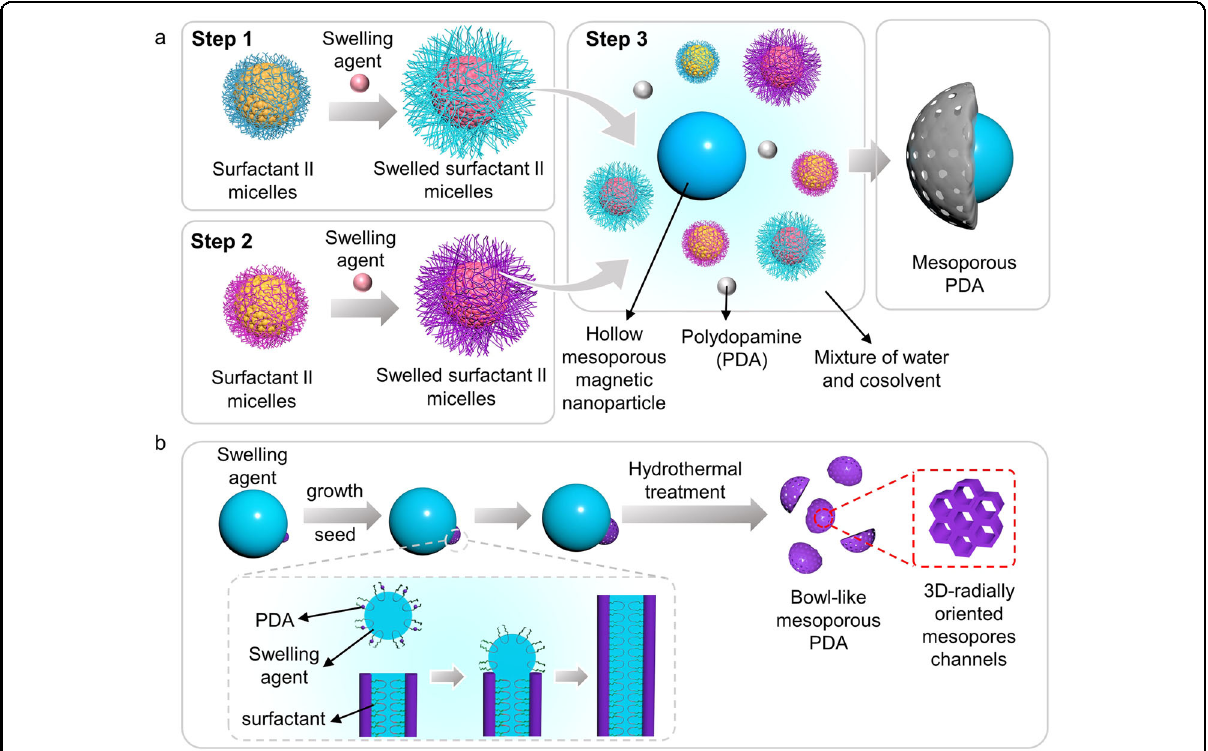
Fig. 3 Schematic diagram of the preparation of mesoporous polydopamine. a Dual surfactants as the template and ( b ) seed-growth